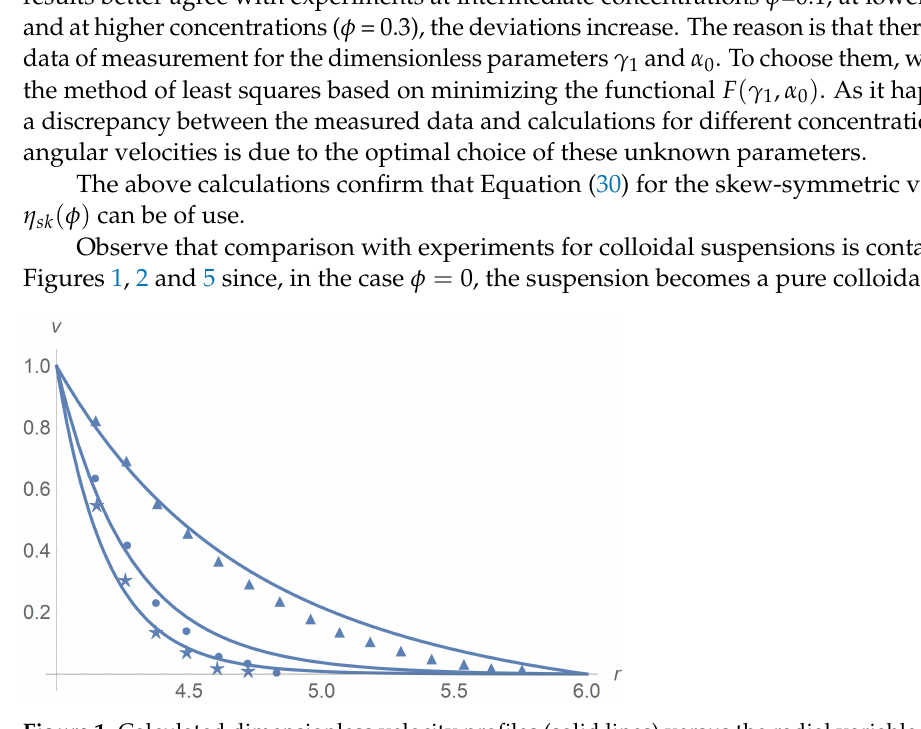
Figure 1. Calculated dimensionless velocity profiles (solid lines) versus the radial variable for pure interstitial Herschel–Bulkley fluid without particles, φ = 0. The lines from the bottom upward correspond to Ω = 2, Ω = 5 and Ω = 100, respectively. Stars, balls, and triangles stand for measurement data [9] in the cases Ω = 2, Ω = 5 and Ω = 100, respectively.